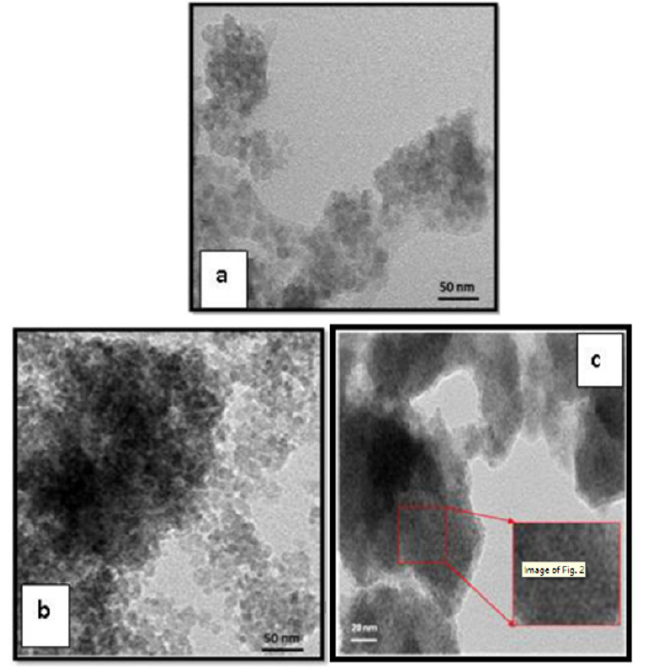
Figure 16. TEM images of ( a ) pure, ( b ) Fe doped, and ( c ) capped ZnO nanoparticles. Re- printed/adapted with permission from Ref. [192]. Copyright© 2022 , Elsevier B.V.